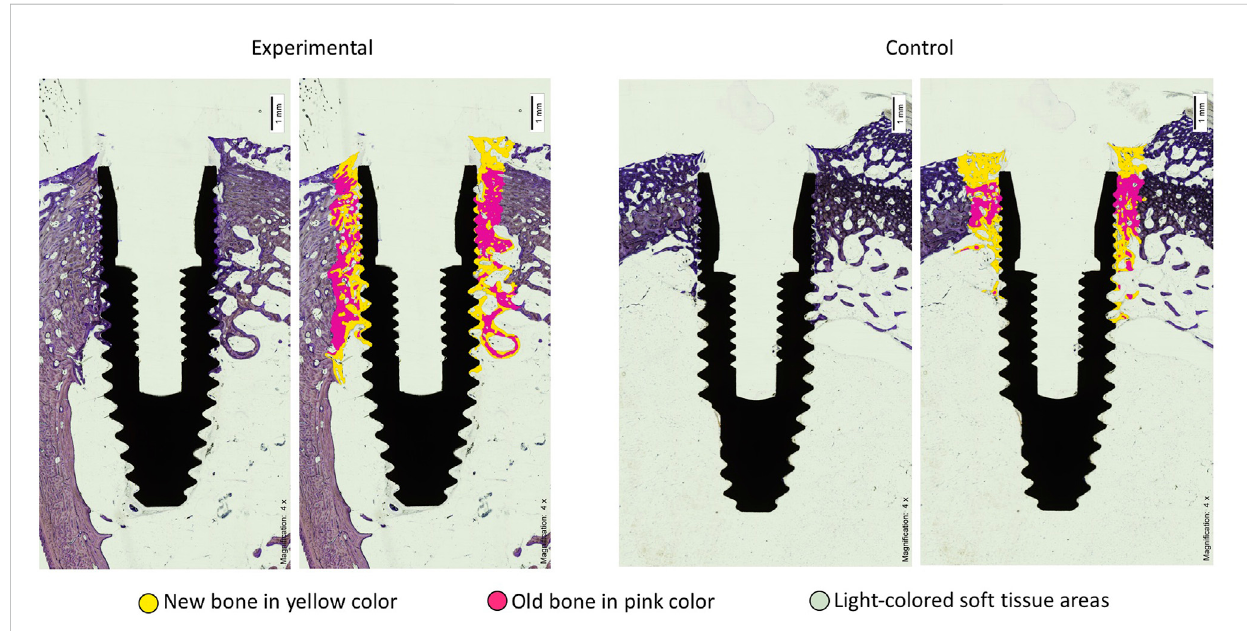
FIGURE 1 Histomorphometric section images of the BIC of implants in the Acid-BMP-7 (experimental) and SLA (control) groups after four weeks. The yellow color is new bone, more abundant and with greater contact with the implant surface in the experimental group compared to the control group.